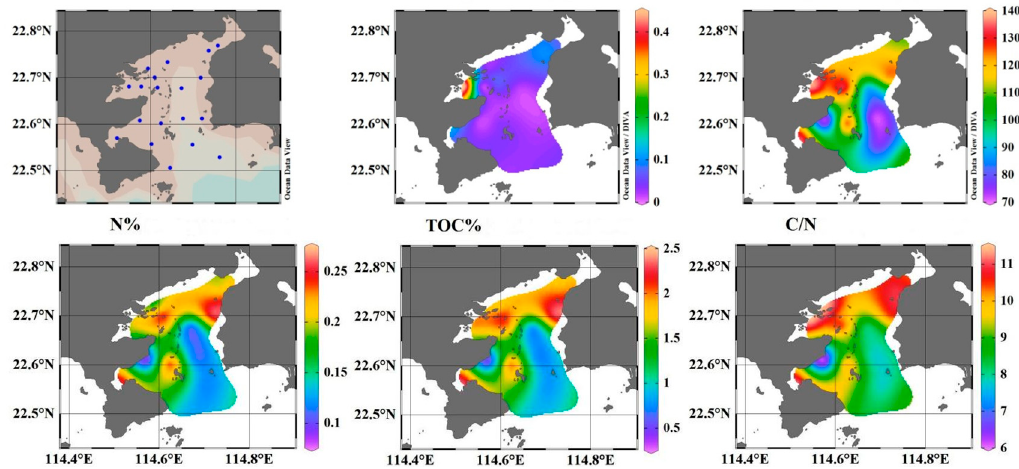
Figure 3. Spatial distributions of heavy metals concentrations, total organic content (TOC), total nitrogen (TN), and carbon-nitrogen ratio (C/N) in the sediment of Daya Bay, China.